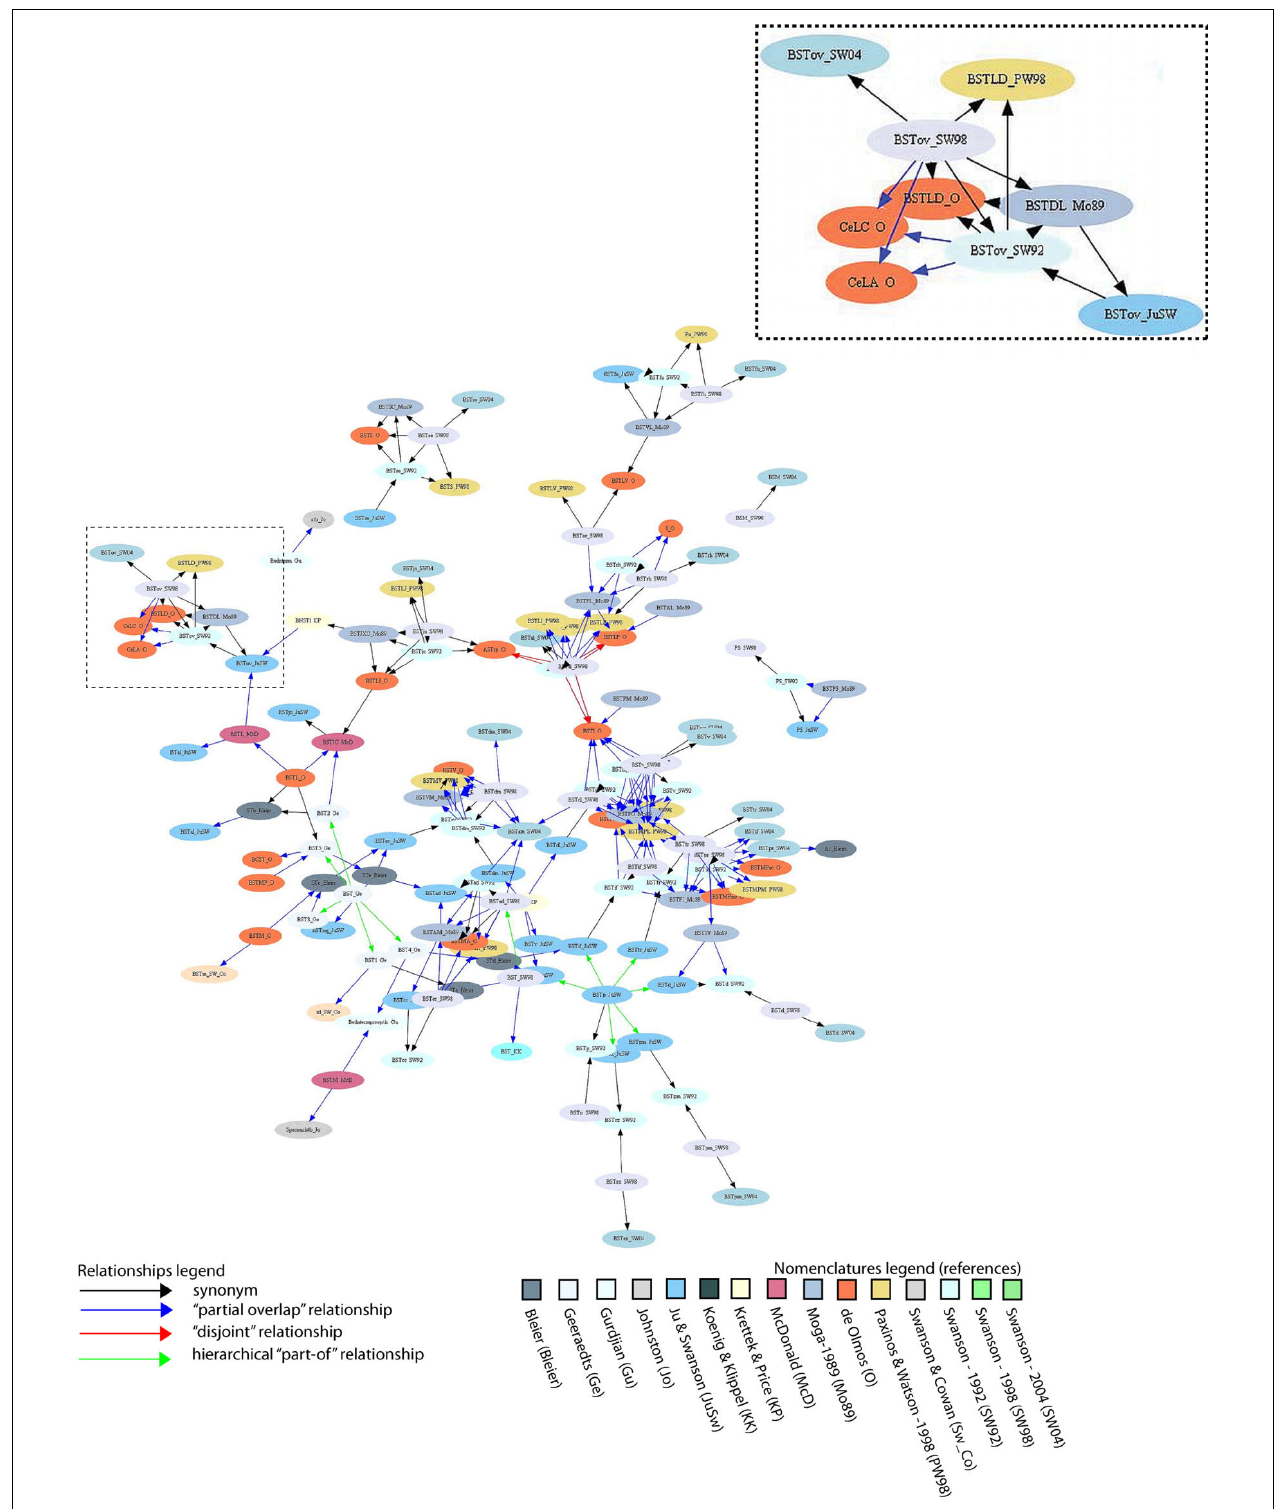
FIGURE 9 | Graphical display of BST-related terms defi ned in 15 nomenclatures, and their semantic relations (“the knowledge map”). The graph was obtained using GraphViz’s Neato tool (Gansner and North, 1999; Bota and Swanson, 2007b). A higher resolution version of this Figure can be found at